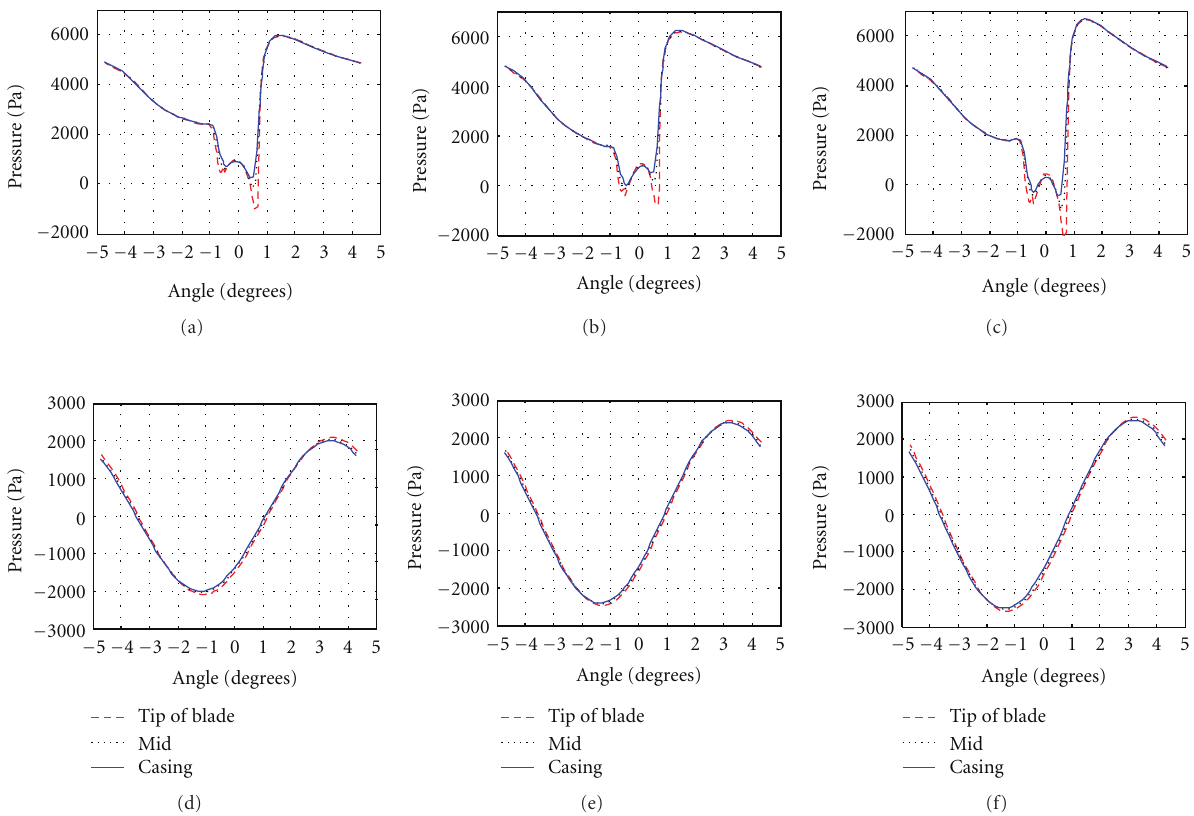
Figure 14: Pressure across the three polylines, shown in Figure 4(d), when the blade deflection is (a) at a maximum, (b) at a mean, and (c) at a minimum, for the case of 0.5mm gap. (d), (e), and (f) are the first spatial harmonic of the pressure across the same polylines for the respective blade displacements. Note the angle given is relative to the centre of the